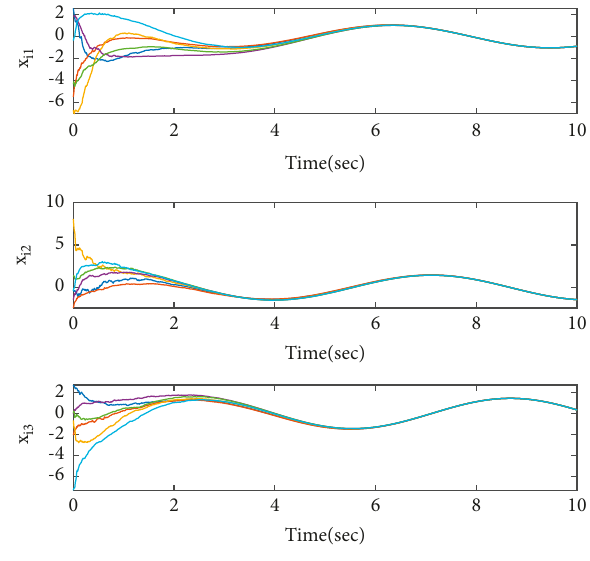
Figure 2: States of 6 agents of Example 1.